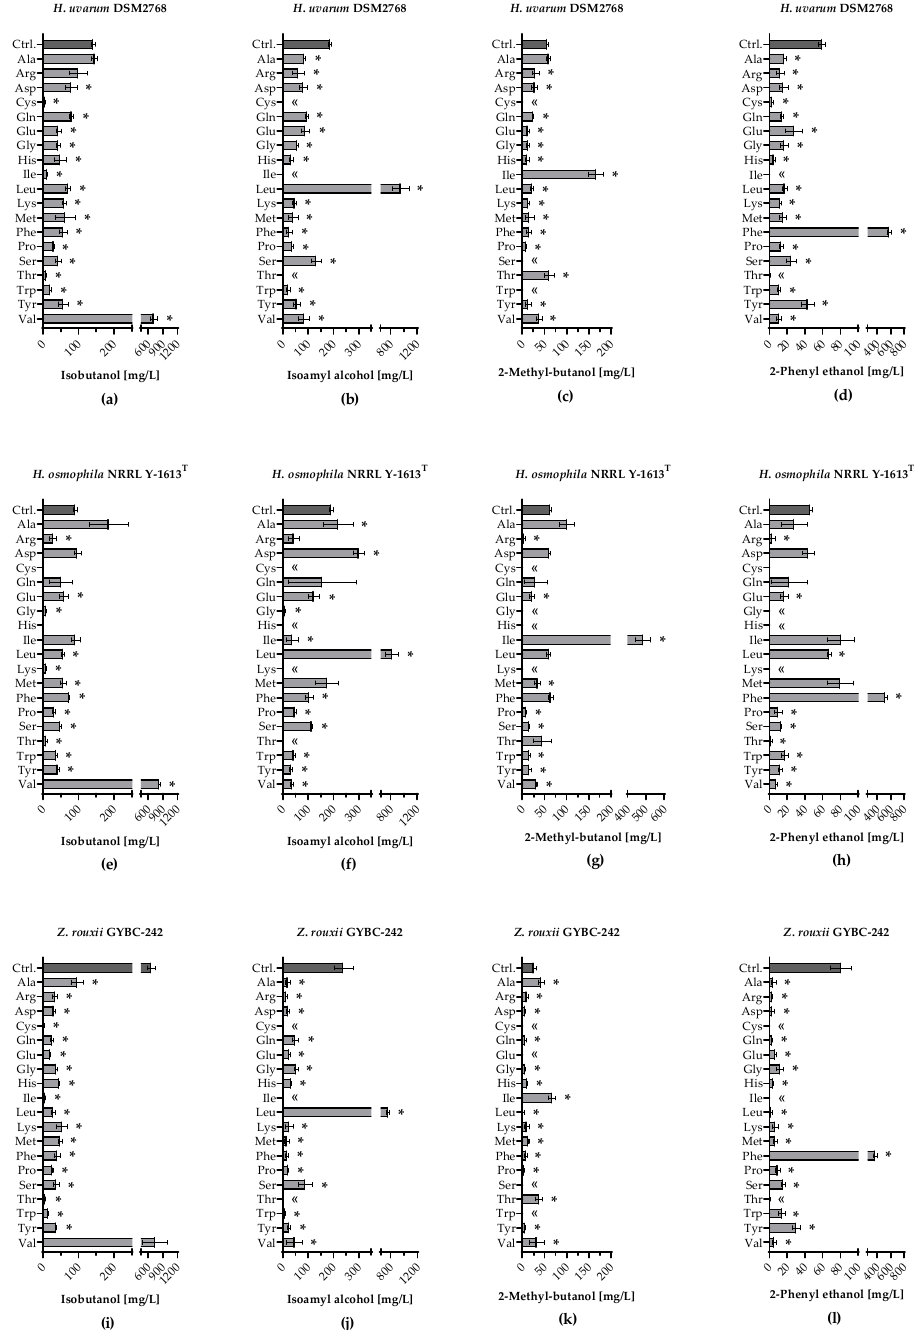
Figure 6. Formation of higher alcohols during fermentation with individually supplemented amino acids. Formation of isobutanol [mg/L] in fermentations using ( a ) H. uvarum DSM2768, ( e ) H. osmophila NRRL Y-1613 T and ( i ) Z. rouxii GYBC-242. Formation of isoamyl alcohol [mg/L] in fermentations using ( b ) H. uvarum DSM2768, ( f ) H. osmophila NRRL Y-1613 T and ( j ) Z. rouxii GYBC-242. Formation of 2-methyl butanol [mg/L] in fermentations using ( c ) H. uvarum DSM2768, ( g ) H. osmophila NRRL Y-1613 T and ( k ) Z. rouxii GYBC-242. Formation of 2-phenyl ethanol [mg/L] in fermentations using ( d ) H. uvarum DSM2768, ( h ) H. osmophila NRRL Y-1613 T and ( l ) Z. rouxii GYBC-242. Fermentations using the respective yeast with SM-mix served as control (Ctrl.). Higher alcohols were measured via HS-SPME-GC-MS analysis. Data are the mean of three independent experiments ± SEM, two-tailed unpaired t test with Welch’s correction, * p < 0.05 as compared to the control. Error bars indicate the standard deviation; «: not